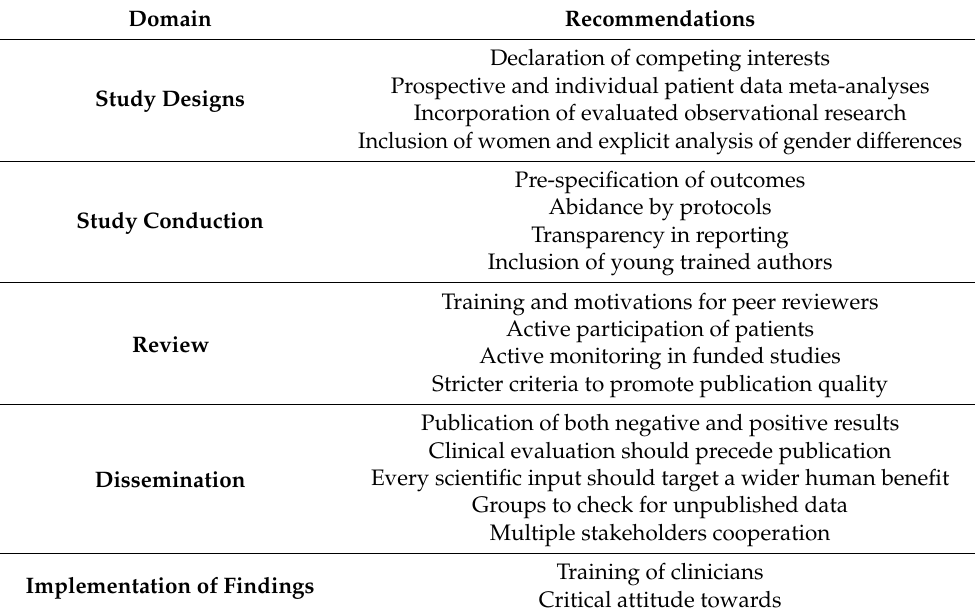
Table 1. Summary of the recommendations for the steps towards evidence